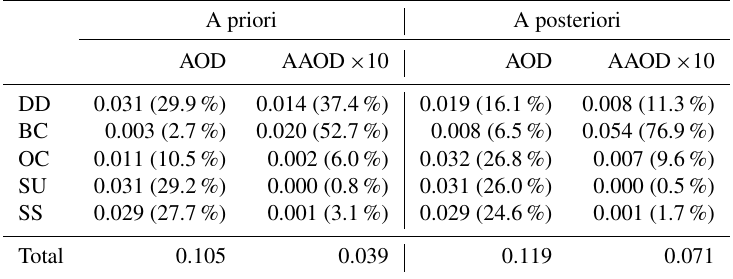
Table 3. Global mean AOD and AAOD at 550nm of five major aerosol components. Numbers in parenthesis are relative contributions of different components to AOD and AAOD at 550nm. Statistics are based upon a priori and a posteriori GEOS-Chem simulations for the year